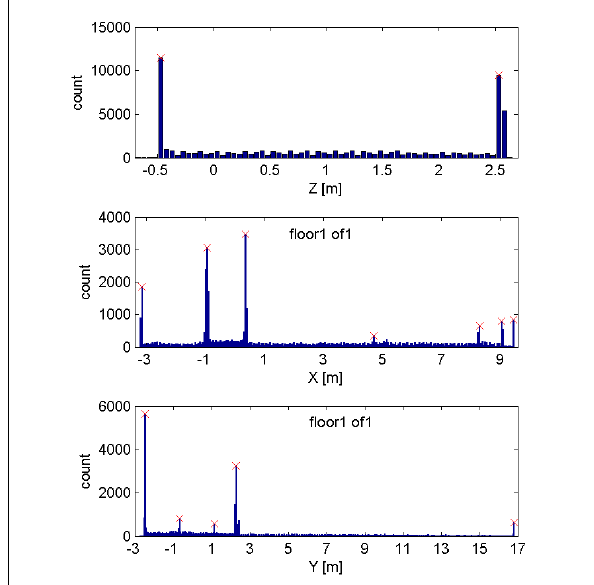
Figure 11. Histograms of z- , x - and y coordinates for the real point cloud and the extracted peaks.